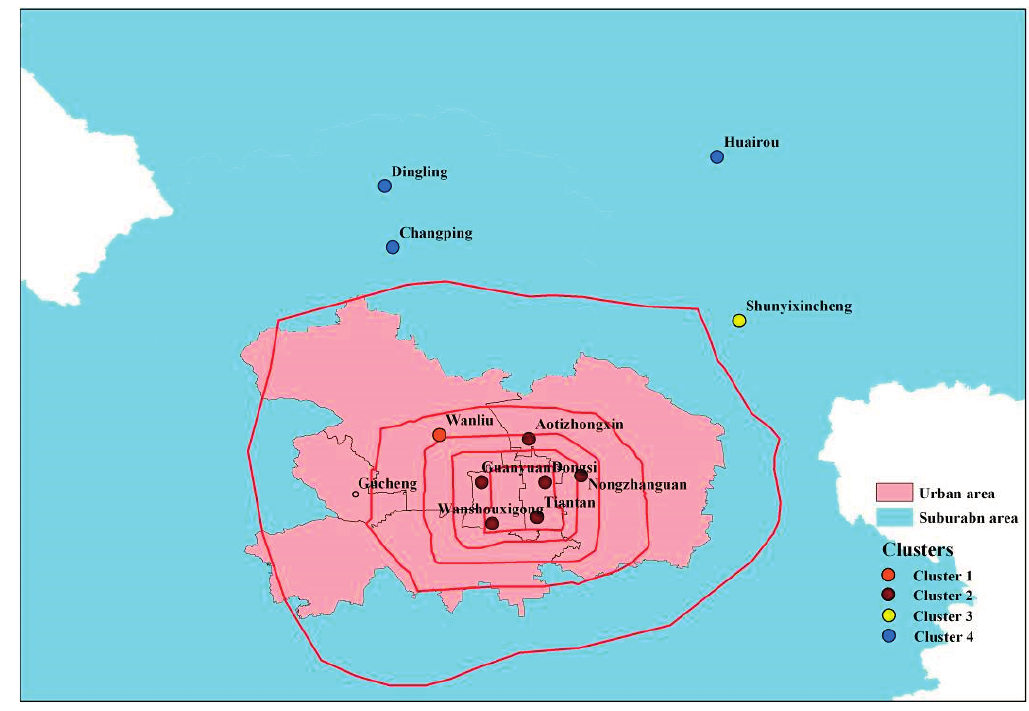
Figure 2. K-means clusters for urban and suburban stations. Stations are clustered into four categories. Cluster 1 and 2 locate in urban and the others locate in suburban. The average PM 2.5 concentration decreases from cluster 1 to cluster 4. The red lines represent the six ring roads in